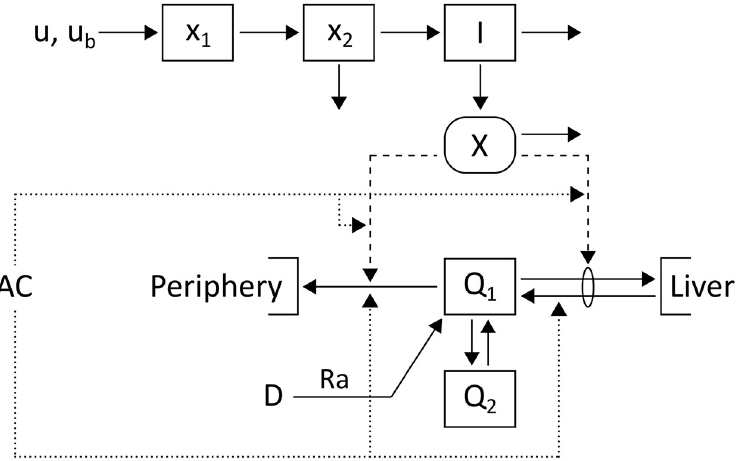
Fig 1. Schematic of the glucose-insulin model. Glucose, Q 1 , and insulin, I , dynamics are described using a two- compartment model [33]. Extensions capture plasma insulin kinetics after subcutaneous injection u with basal insulin infusion rate u [34] and glucose appearance with rate Ra after a meal D [35]. PA is measured via accelerometer counts b AC and leads to changes in glucose metabolism indicated by dotted